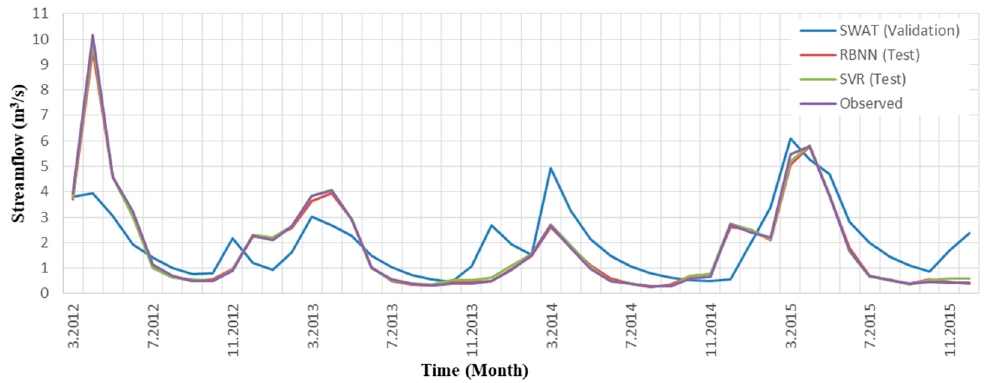
Figure 8. Time series of SWAT (validation), RBNN (test) and SVR (test) methods.